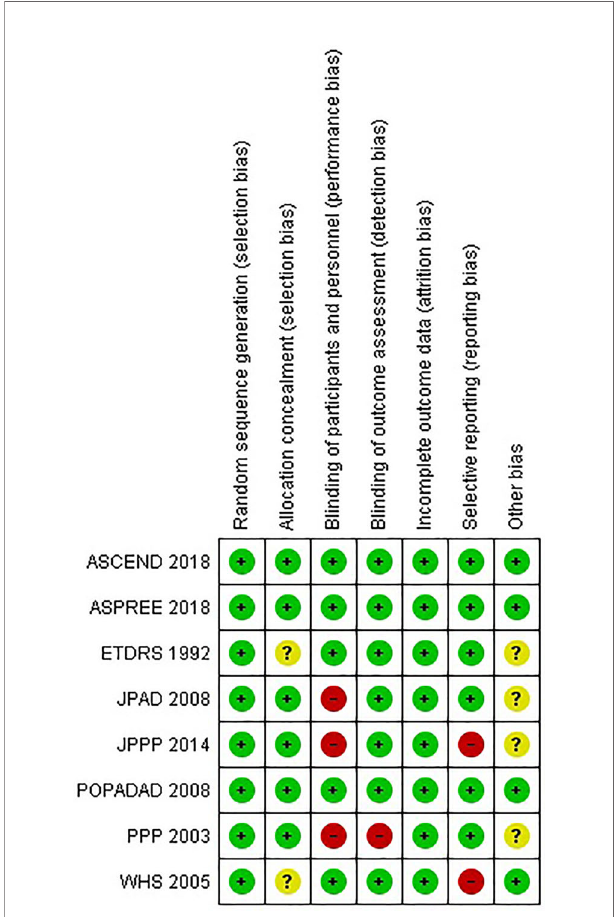
FIGURE 1 | Risk of bias summary for studies included in the